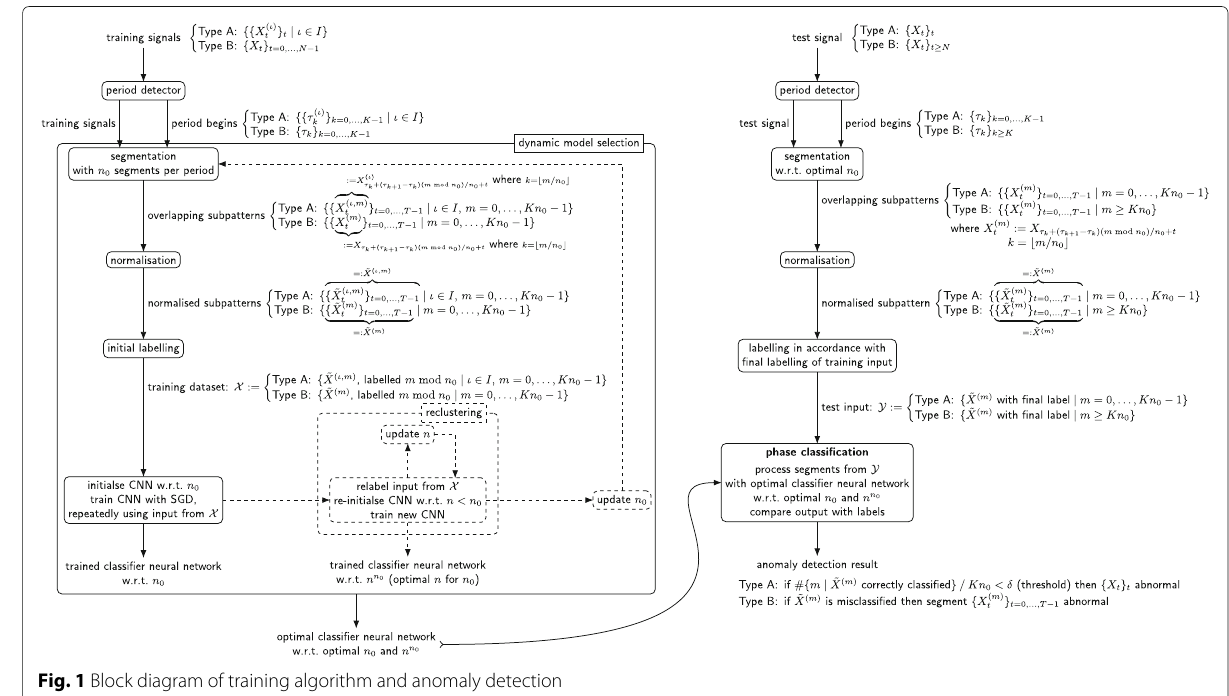
Fig. 1 Block diagram of training algorithm and anomaly